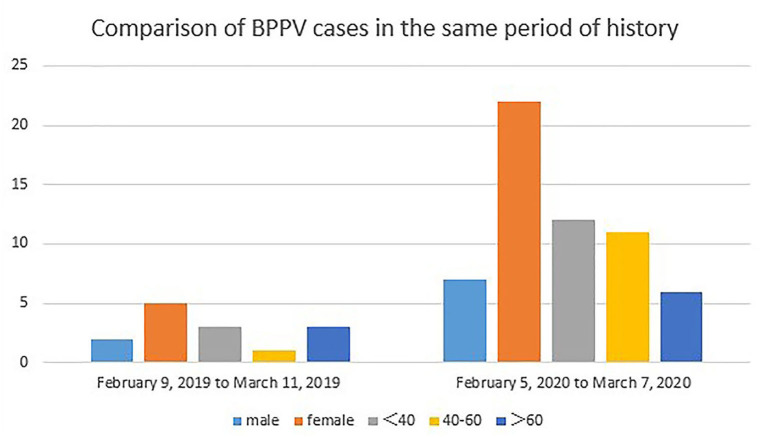
The BPPV of young and middle-aged and total cases increased significantly during the period of 30 days in the quarantine policy of COVID-19 than in the same period last year.